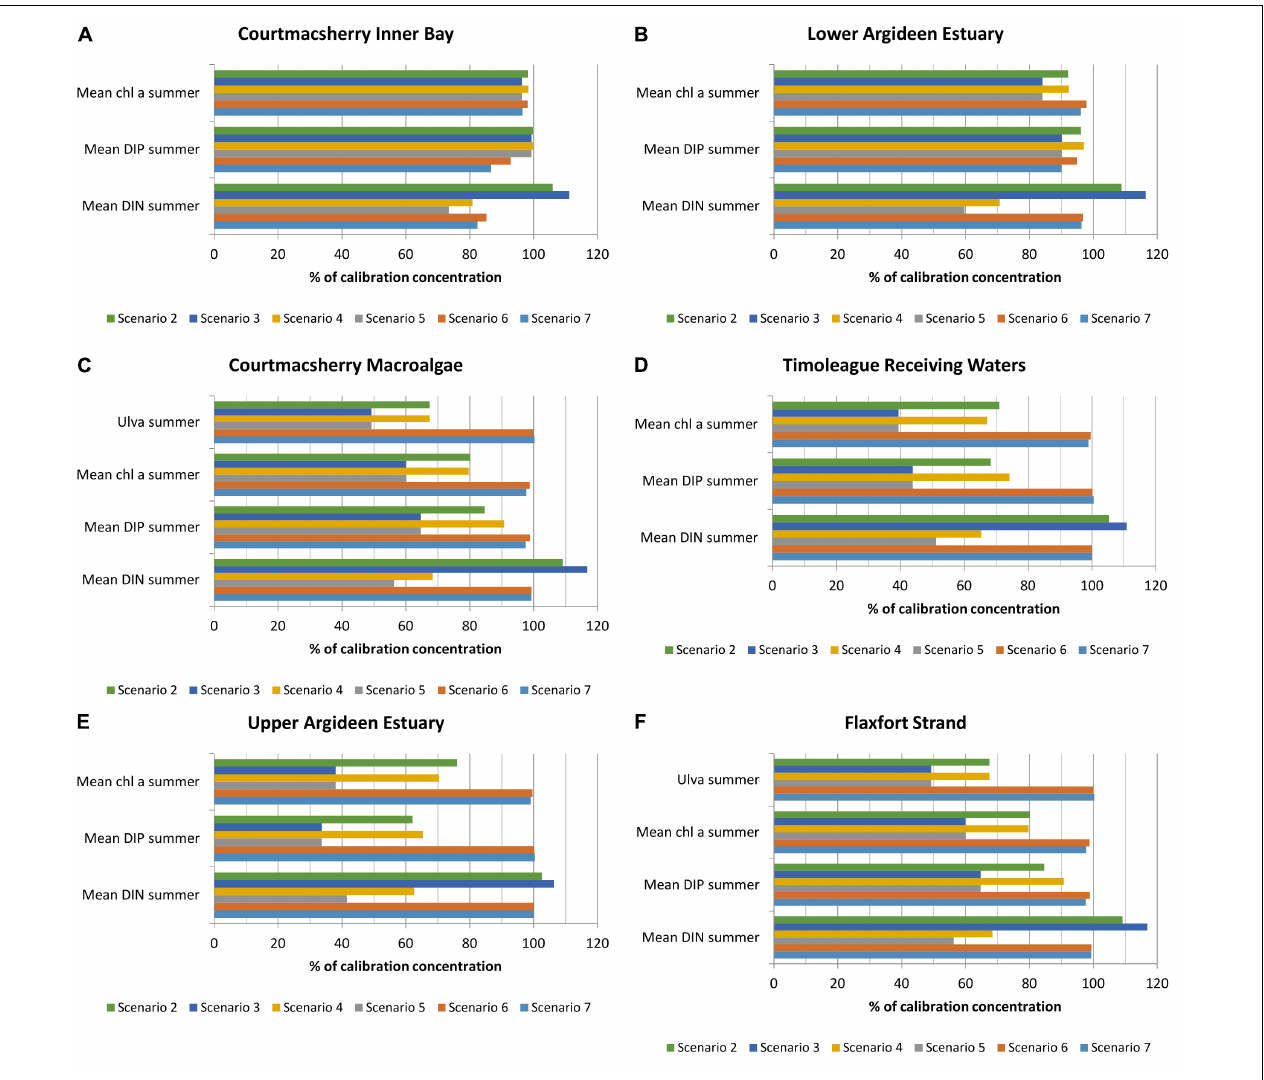
FIGURE 7 | Percentage change in DIN, DIP, chlorophyll a and macroalgae due to riverine nutrient load reduction or boundary reduction based on 2016 loading data in (A) Courtmacsherry Inner Bay, (B) the Lower Argideen Estuary, (C) the Courtmacsherry macroalgae zone, (D) the Timoleague Receiving Waters, (E) the Upper Argideen Estuary, and (F) Flaxfort